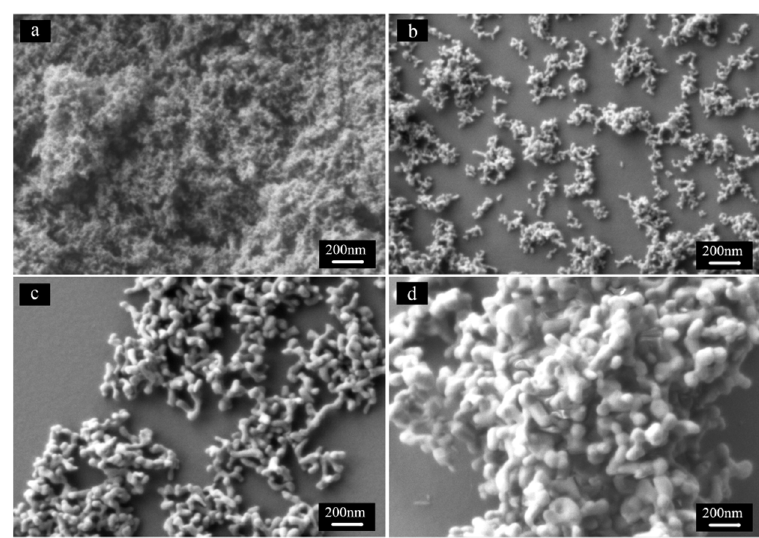
Figure 5. SEM images of the calcined S7 at different temperature for 3 h. ( a ) 800 °C; ( b ) 900 °C; ( c ) 1100 °C; ( d ) 1200 °C.